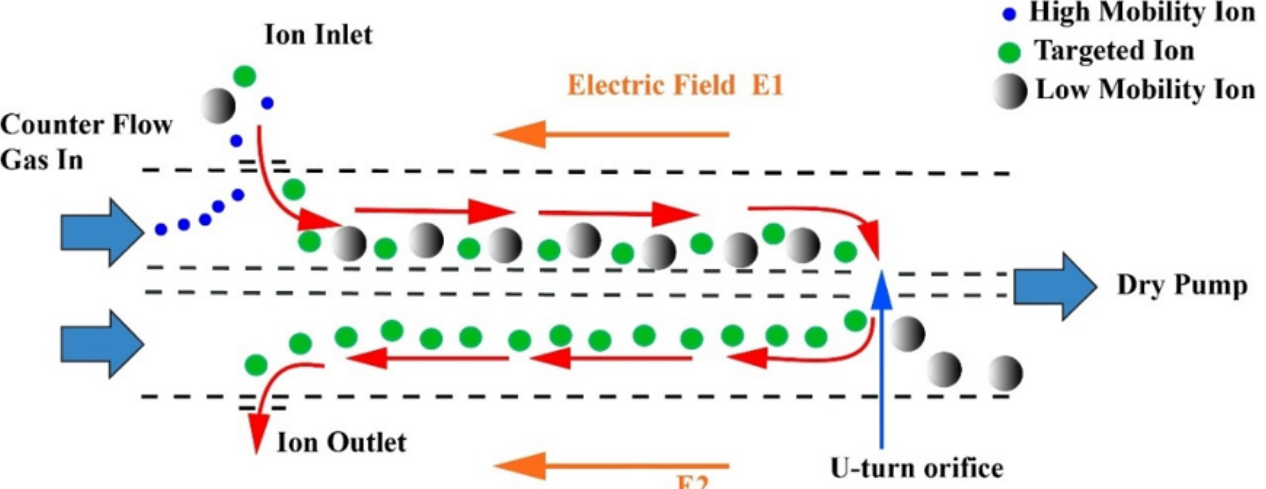
Figure 7. Schematic diagram of the U-shaped mobility analyzer. Red arrows indicate the ion path.